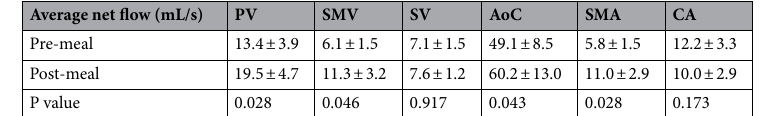
Table 1. Average flow results in volunteer cohort. PV portal vein, SV splenic vein , SMV superior mesenteric vein, AoC aorta at coeliac artery, SMA superior mesenteric artery, CA coeliac artery.